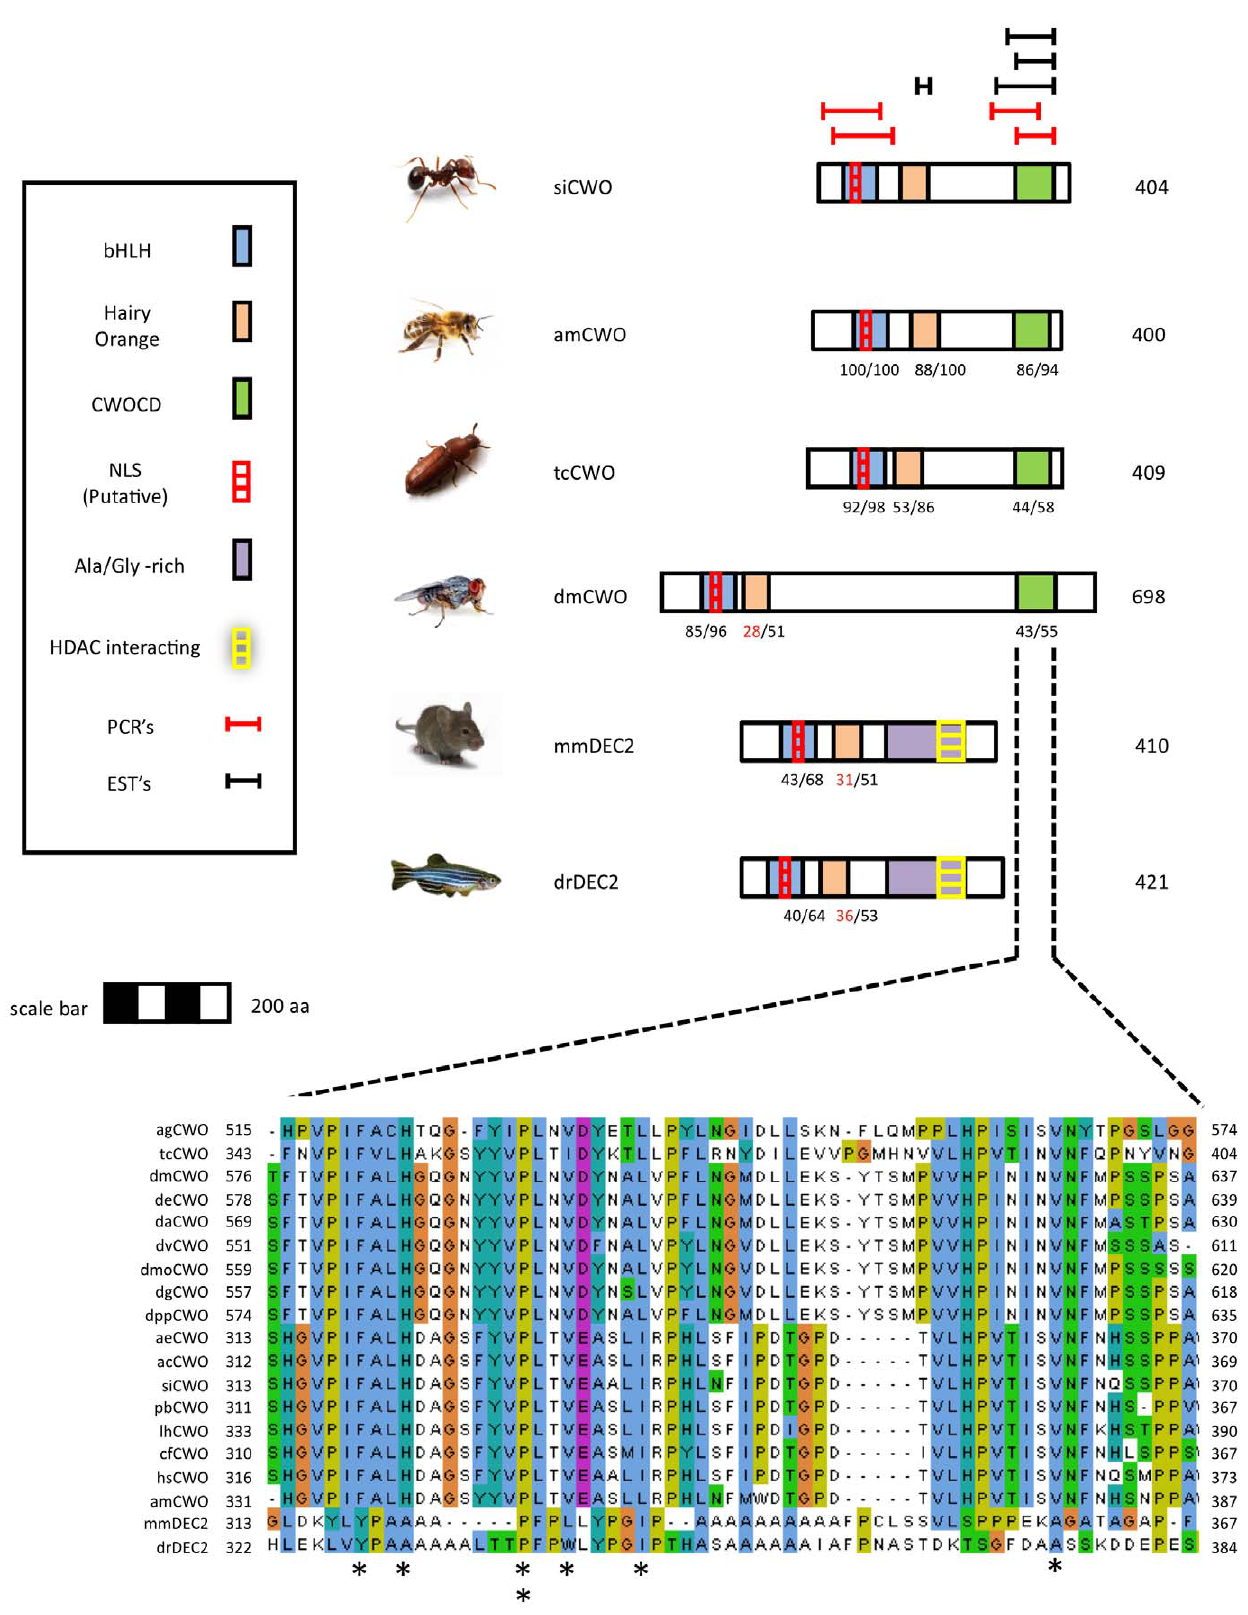
Figure 4. Schematic models for Clockwork Orange (CWO) proteins from various insects. The depicted models are for the fire ant Solenopsis invicta (siCWO), the honey bee Apis mellifera (amCWO), the fruit fly Drosophila melanogaster (dmCWO), Red Flour Beetle Tribolium castaneum (tcCWO). Also shown are related proteins from the house mouse Mus musculus (mmDEC2) and zebrafish Danio rerio (drDEC2). Highlighted